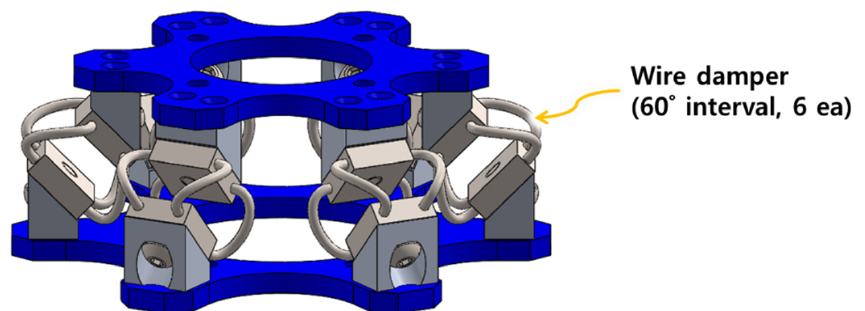
Figure 6. Sunshade for multi-modal sensor module.